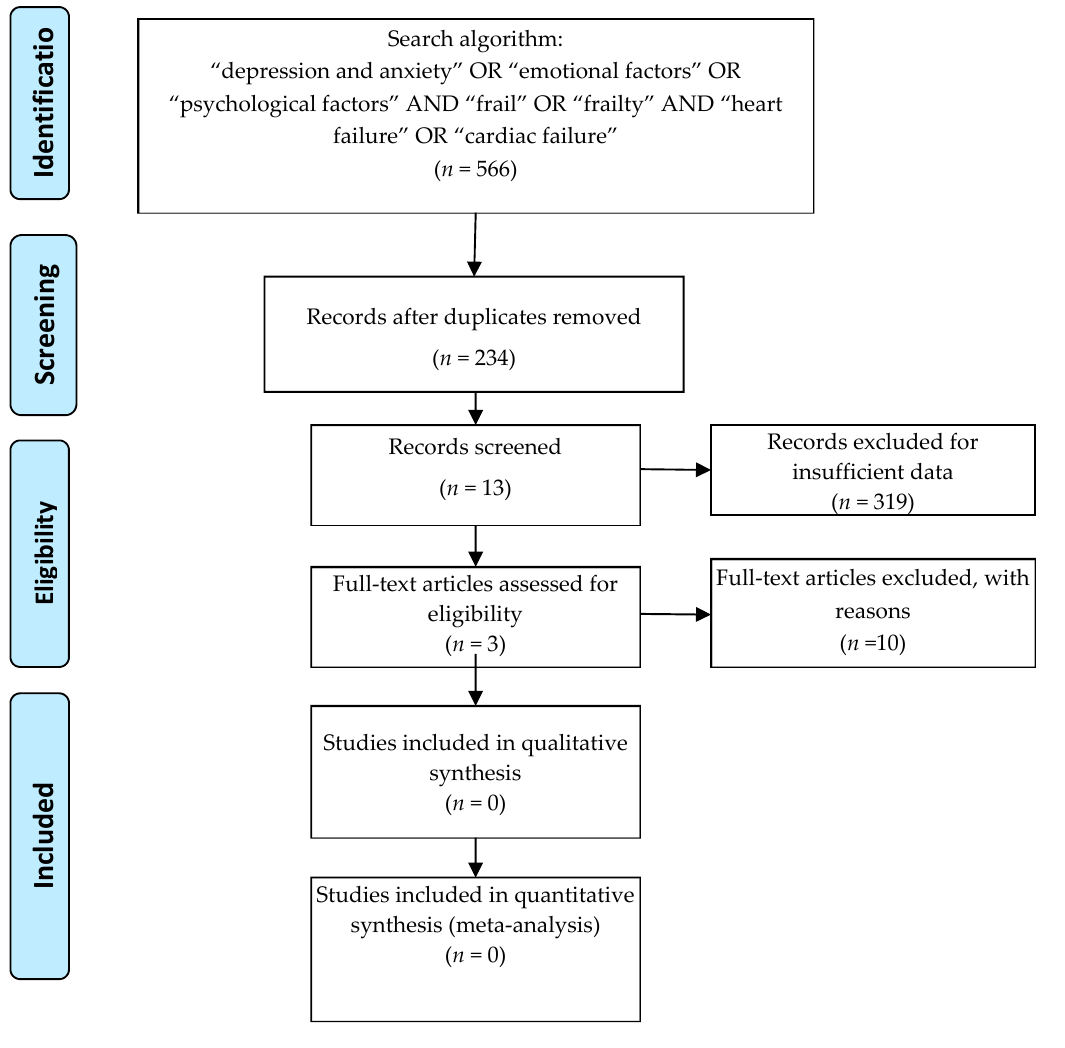
Figure 1. Selection of the